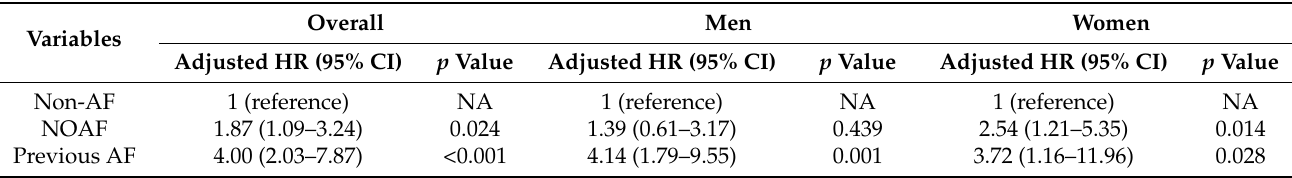
Table 2. Cox-regression analyses of the associations between each AF subgroup and the risk of ischemic stroke after hospital discharge.